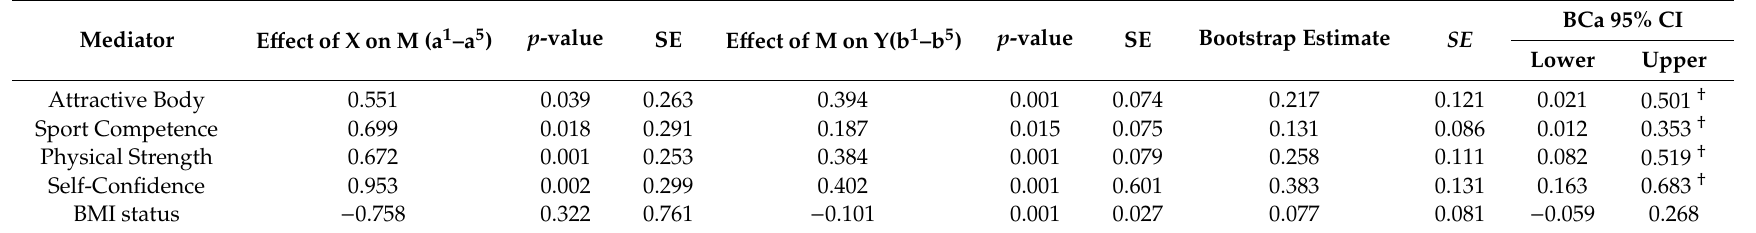
Table 2. Indirect e ff ect of gender (male / female) on overall physical fitness of adolescent students through attractive body, sport competence, physical strength, self-confidence, and body mass index (BMI)